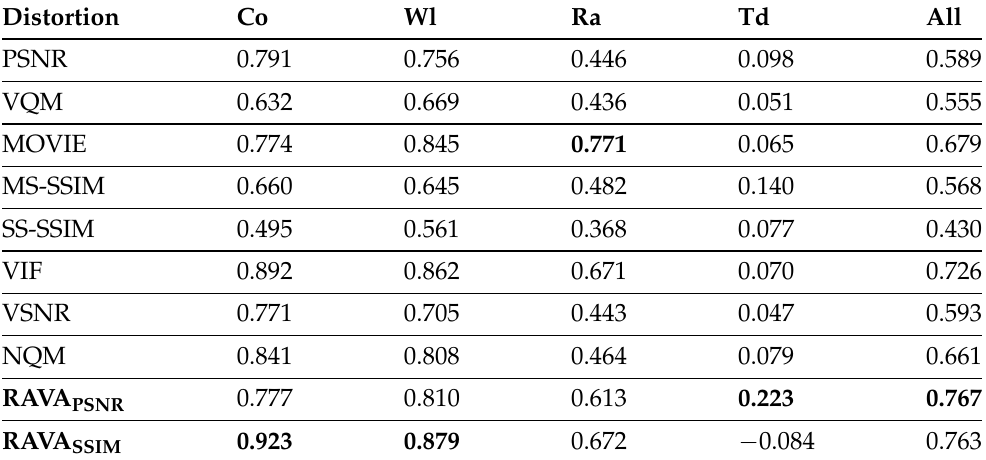
Table 4. Comparison of SCC (Spearman correlation